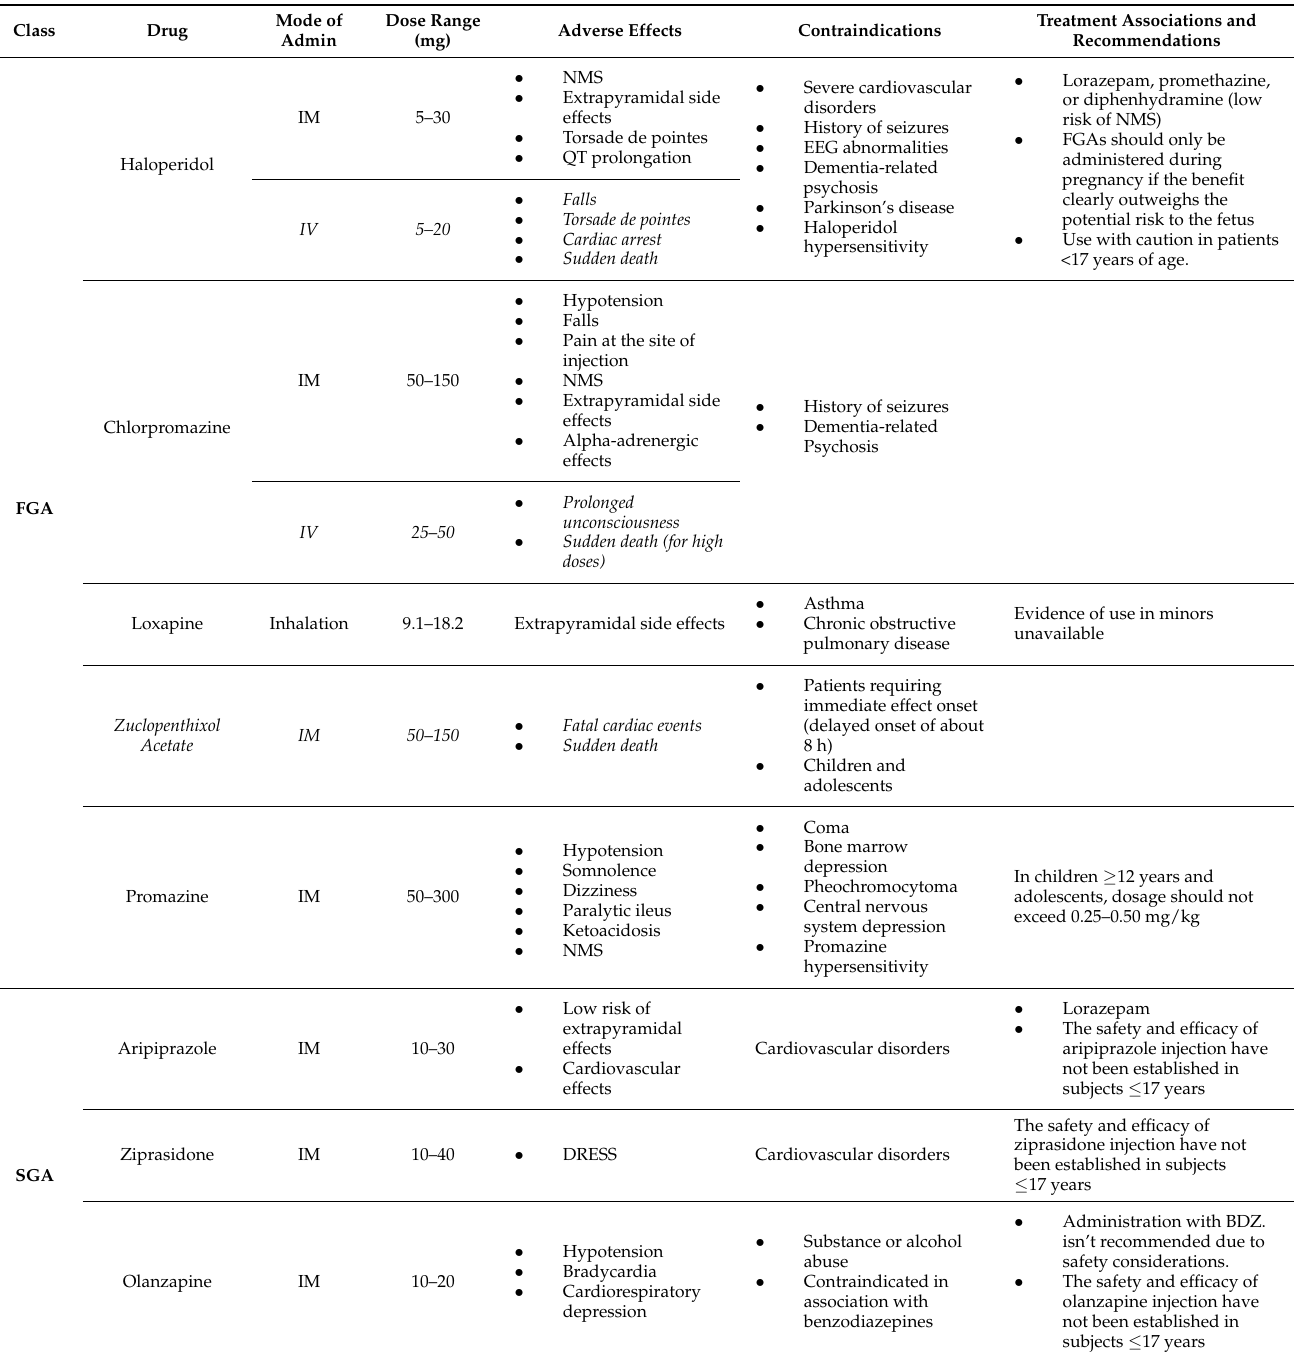
Table 2. Parenteral and inhaled pharmacological treatments for psychomotor